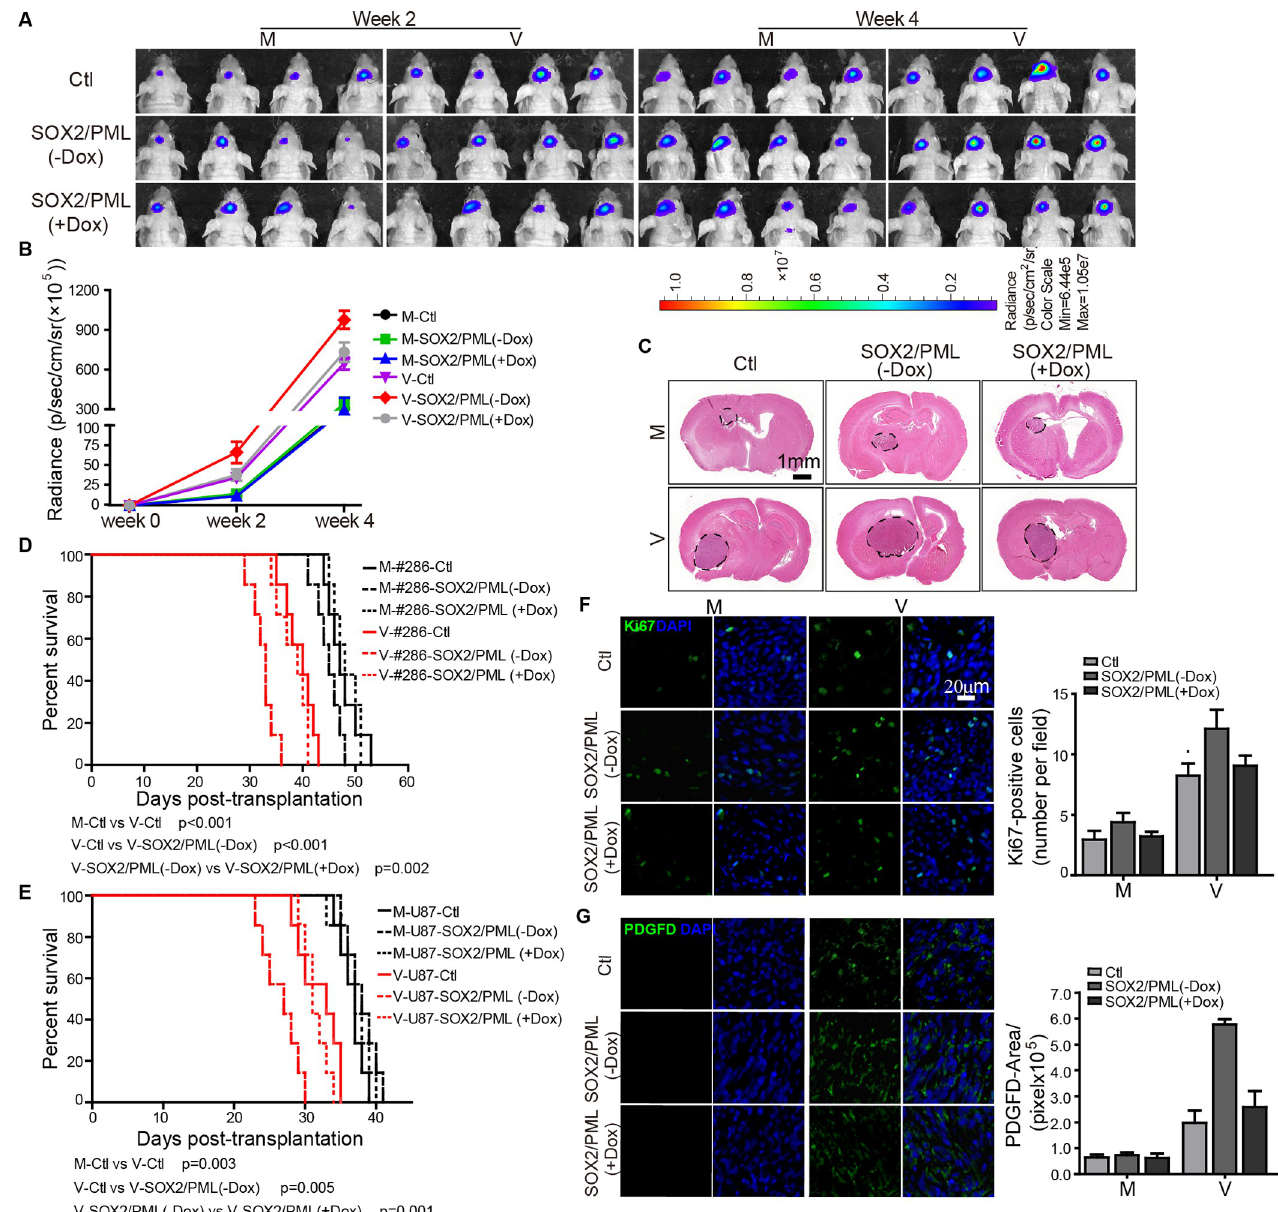
Fig 6. SOX2 enhances the oncomodulatory activities of HCMV in a patient-derived xenograft GBM model. Patient-derived #286-luc-Ctl (Ctl) and #286-luc-SOX2/PML (-Dox) cells were mock-infected (M) or infected by HCMV Towne strain (V) for three hours and then implanted into the brains of BALB/c nude mice. PML expression was induced by treating mice with doxycycline-containing water (+Dox, 2 mg/ml). The tumor growth (n = 7 for each group) was monitored at week 2 and week 4 ( A ) and quantified by luciferase activities ( B ). ( C ) Brain tissues were stained with H&E at four weeks after implantation. Survival curves of #286-luc ( D ) and U87-luc ( E ) tumor-bearing mice of different groups (n = 5 mice/group). Neurological sign free survival is defined as the time from tumor xenotransplantation until the end point without neurologic symptoms, such as unusual involuntary movements. The log-rank test was used to compare animal survival. Representative images and quantification of Ki-67 ( F ) and PDGFD ( G ) immunostaining (green) in the tumors at week 4 are shown. Data were collected from 5 images/mice and n = 3 mice/group. Data in ( B , F and G ) represent means ± SEM (Two-way ANOVA along with the Tukey post-hoc multiple comparisons, the p-values and statistical parameters are provided in Tables E-G in S1 Table).